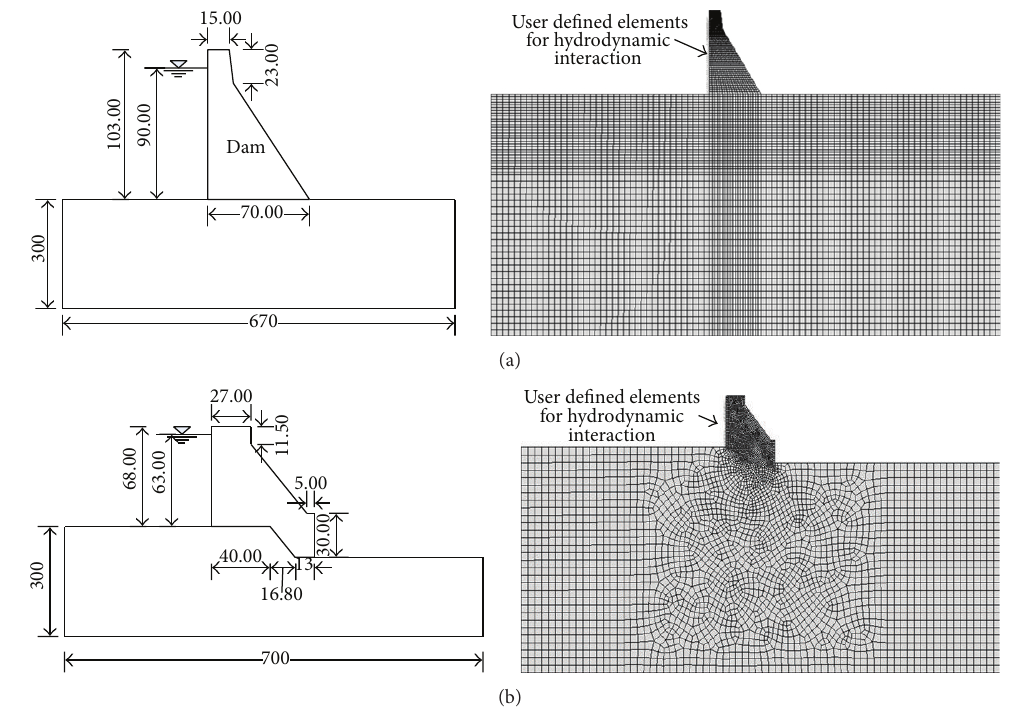
Figure 3: Dam-foundation system: (a) Geometry G-1 and (b) Geometry G-2.